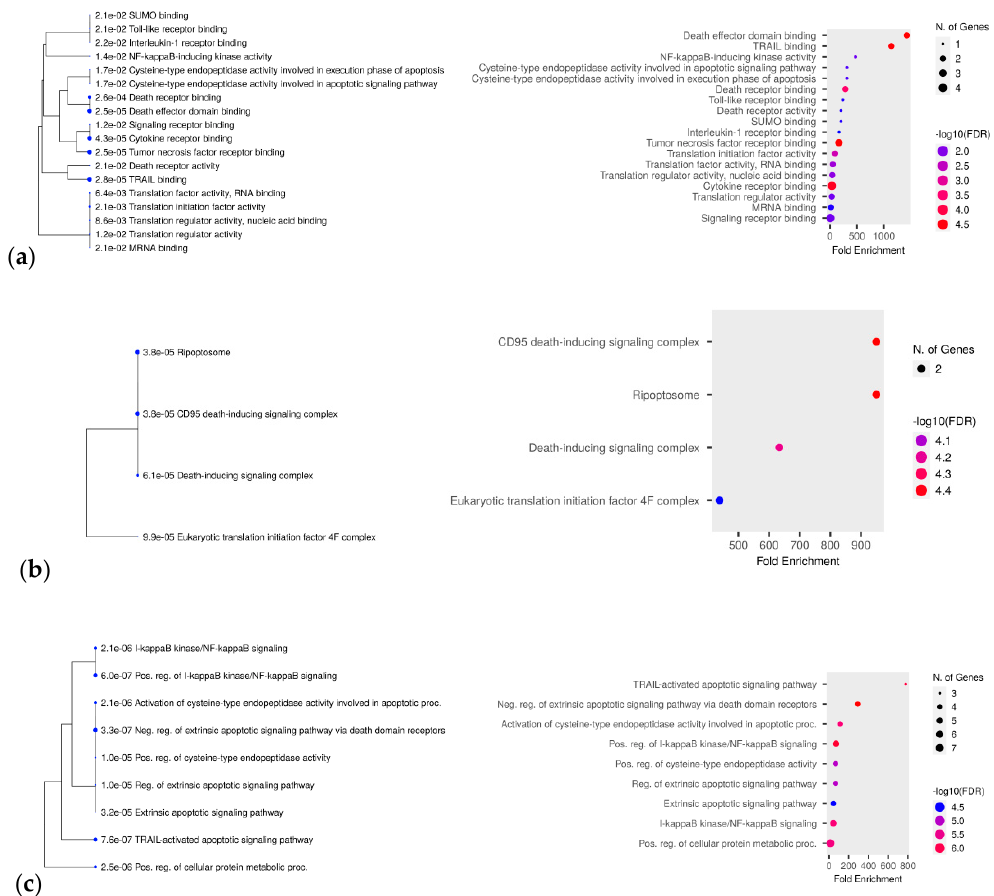
Figure 7. Gene Ontology (GO) function pathways of gene set through ShinyGO. ( a ) Tree and dot plots of GO molecular function; ( b ) cell component; ( c ) biological processes.